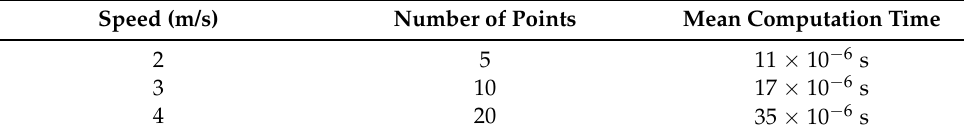
Table 1. Mean computation time.